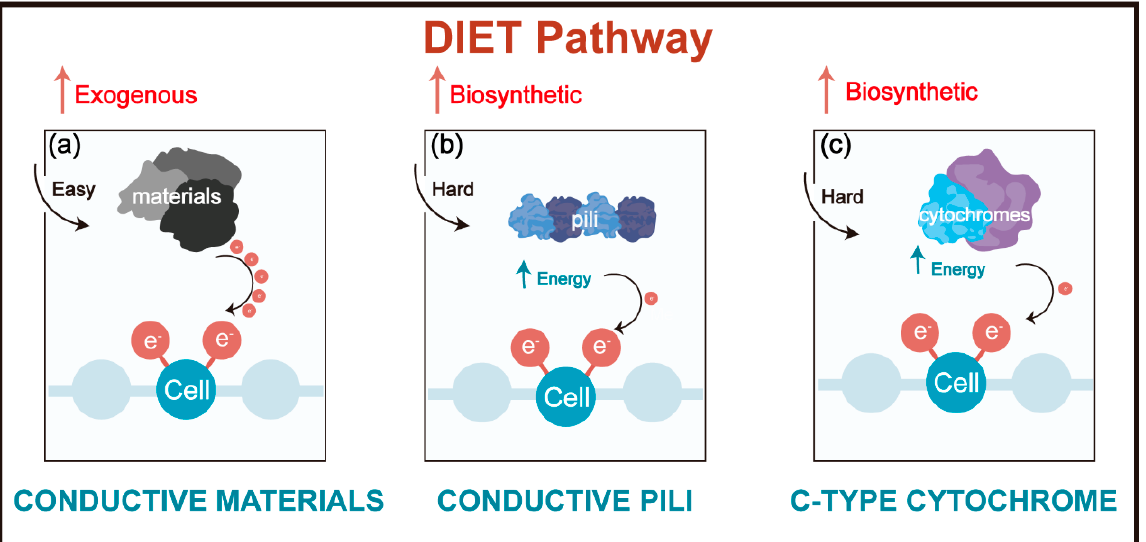
Figure 1. DIET pathways for syntrophic microbes. ( a ) DIET via the conductive material pathway; ( b ) DIET via the conductive pili pathway; ( c ) DIET via the c-type cytochromes pathway.